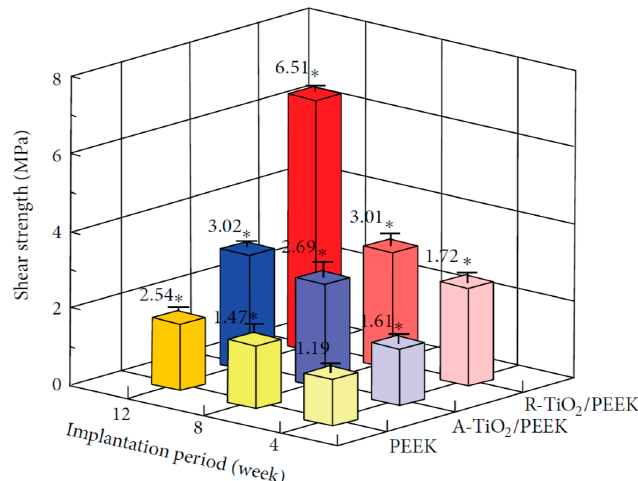
Figure 9. Shear strength between the bone tissue and implant for pure PEEK, A-TiO 2 / PEEK and R-TiO 2 / PEEK at different implantation periods. * p < 0.05 compared to PEEK at 4 weeks after implantation. Reproduced from [129] with permission of Hindawi under the Creative Commons Attribution license.